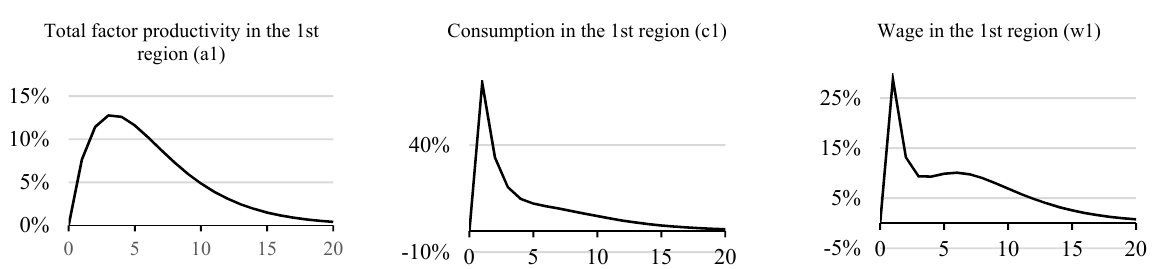
Figure 3. Decrease in GRP, employment, and investment in the first region. At the same time, the growth in aggregate factor productivity increases real wages and consumption (Figure 4). These effects smooth out the decrease in GRP in the first region.